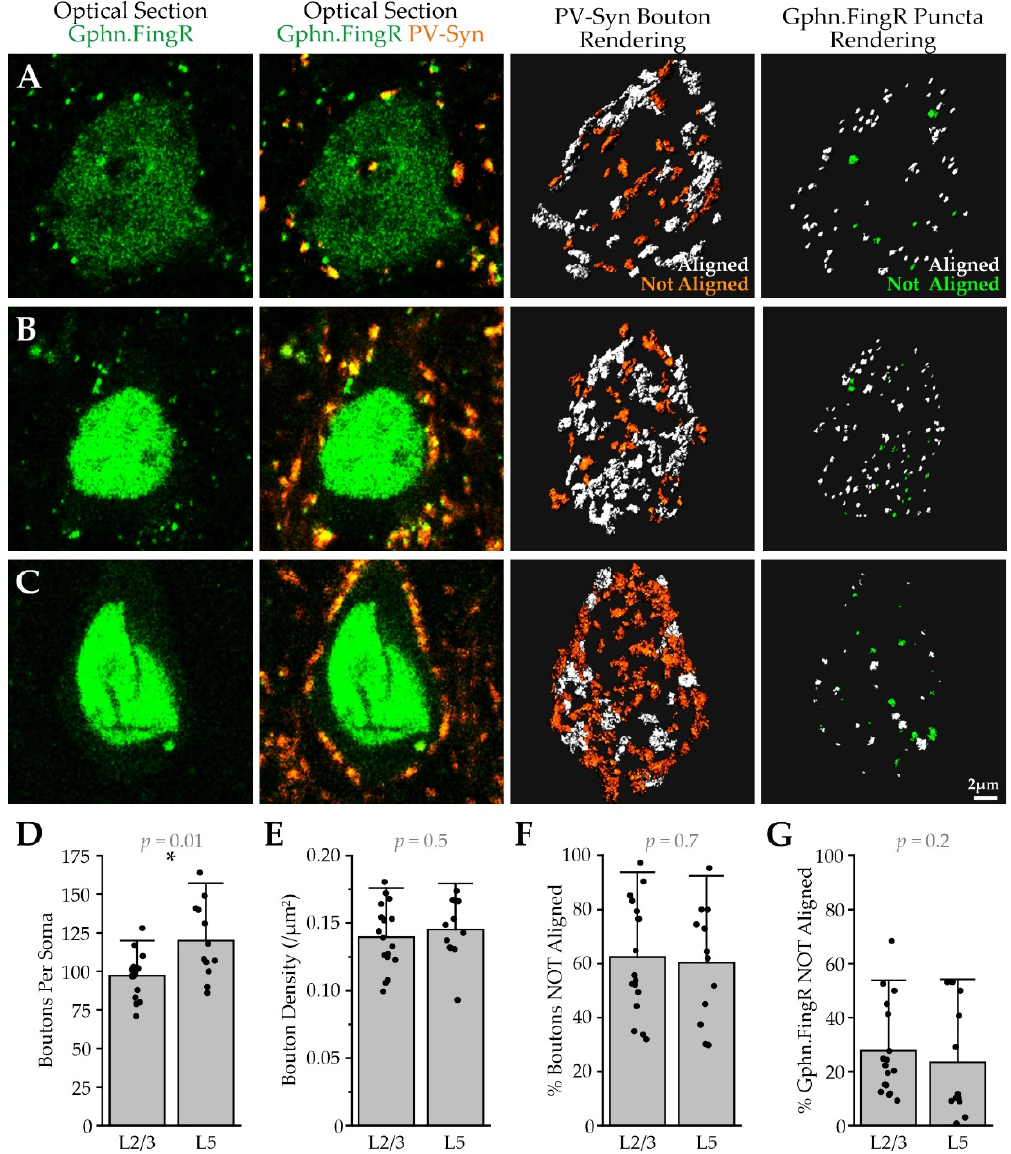
Figure 6. Gephyrin-lacking PV boutons are common on Pyr neuron somas. ( A ) left-to right: optical section of a Pyr neuron soma showing Gephyrin.FingR (green), PV-Syn (orange), dual-channel fluorescence, PV bouton renderings for the cell’s entire soma color-coded by gephyrin alignment, gephyrin renderings color-coded by PV bouton alignment; ( B , C ) as in ( A ), but for two different Pyr neurons; ( D ) the number of PV boutons touching a Pyr neuron soma, * p < 0.05; ( E ) PV boutons at Pyr neuron somas; ( F ) the percentage of somatic PV boutons that could not be aligned with a postsynaptic gephyrin puncta; ( G ) the percentage of somatic gephyrin puncta that could not be aligned with presynaptic PV boutons; L2/3, n =17 cells; L5, n = 12 cells; N = 2 animals.